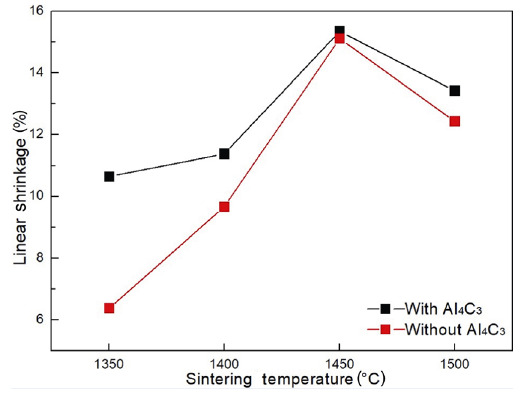
Fig. 7 Dependence of the linear shrinkage on the sintering temperature of Ti 3 AlC 2 sample sintered with or without embedding Al 4 C 3 powders.